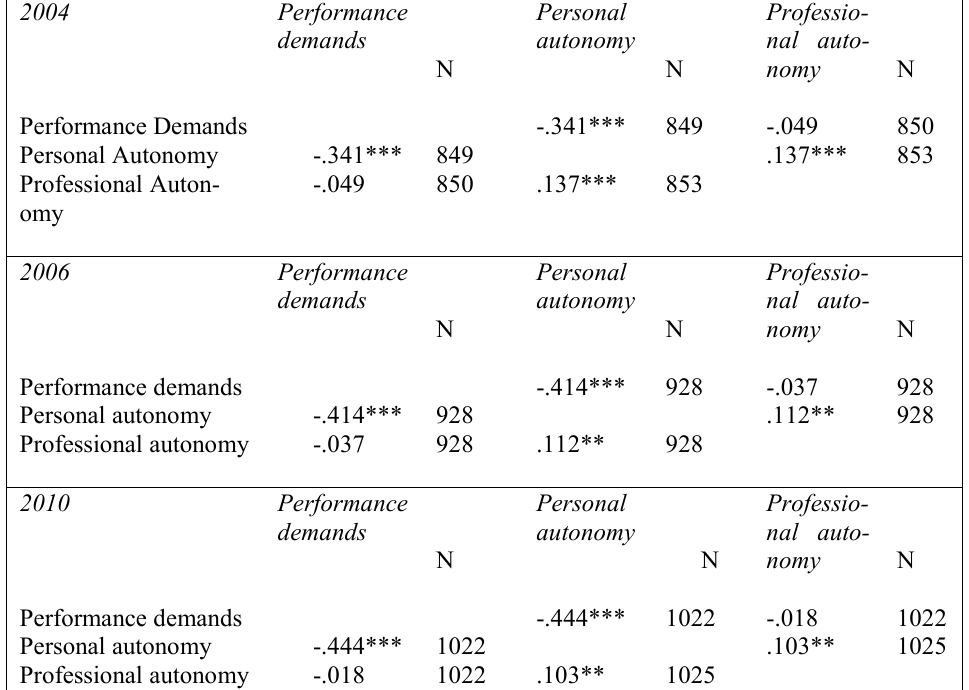
Table 3. Correlation matrix showing the relationship between experienced performance de- mands, personal autonomy, and professional autonomy in 2004, 2006, and 2010